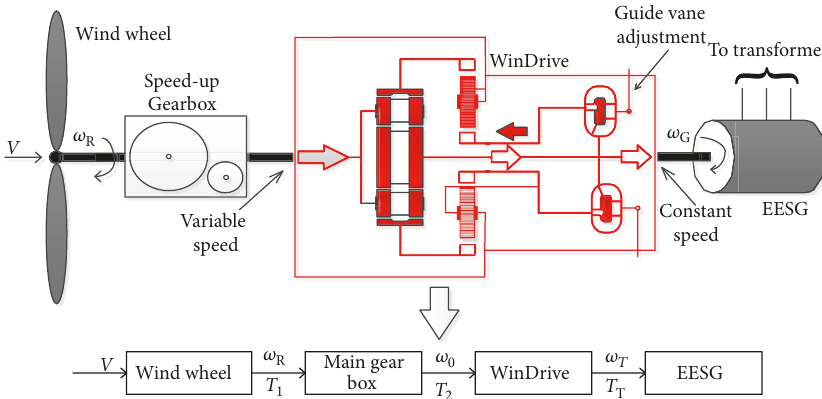
Figure 2: Drive chain of the FSR wind turbine with a hydraulic torque converter (red in the figure).